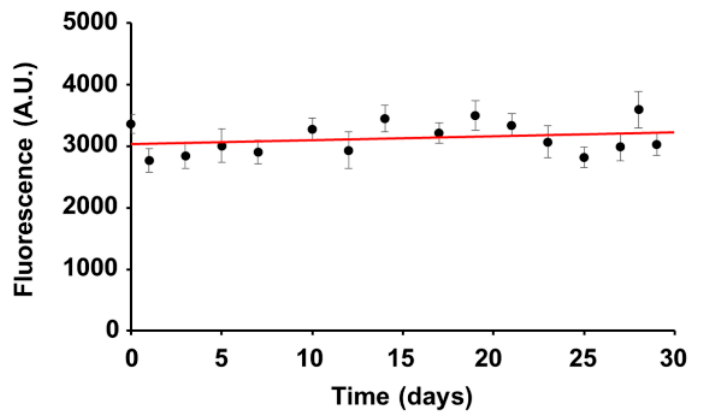
Figure 2. Stability of mtRFP fluorescence intensity in osteosarcoma derived clones. Representative time dependence of the mean fluorescence intensity assayed in mtRFP-positive cells (143B-Clone E) over a month. Linear regression (red line) of the data show that the mean florescence intensity of mtRFP-positive cells was